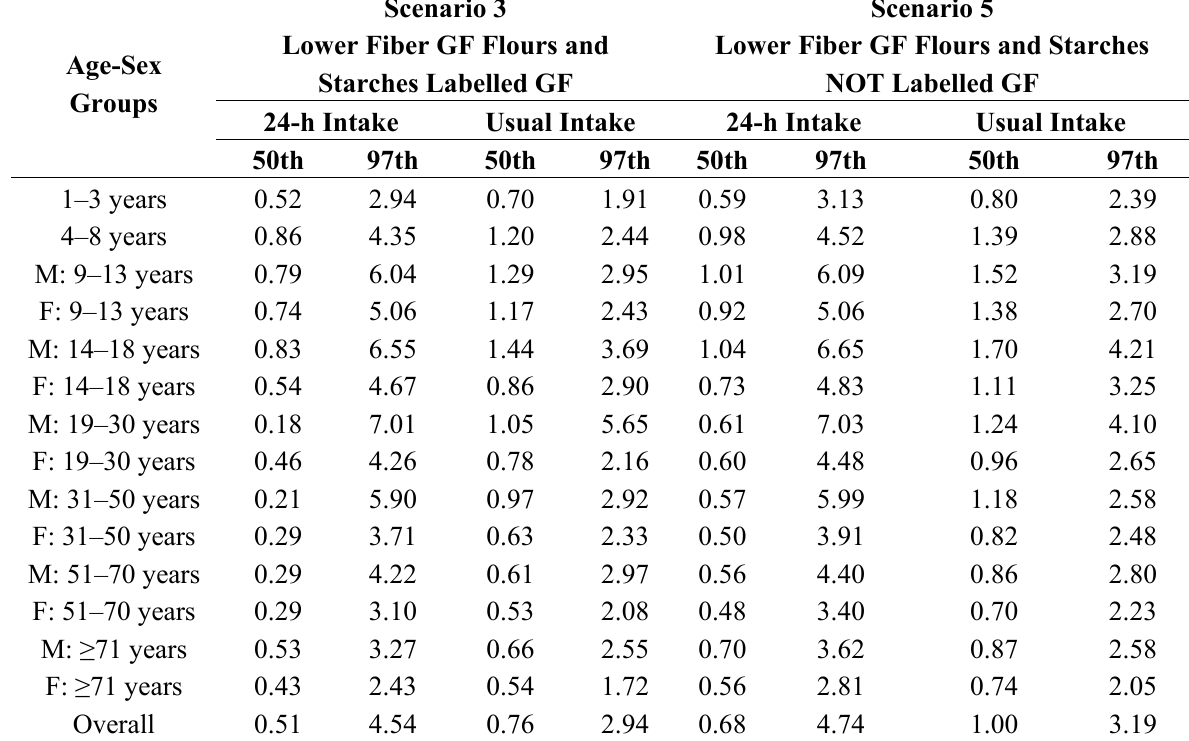
Table 6. Estimated percentiles of gluten exposure (mg/day) in different age-sex groups when many grain-containing foods are prepared at home using traditional lower fiber GF flours and starches.